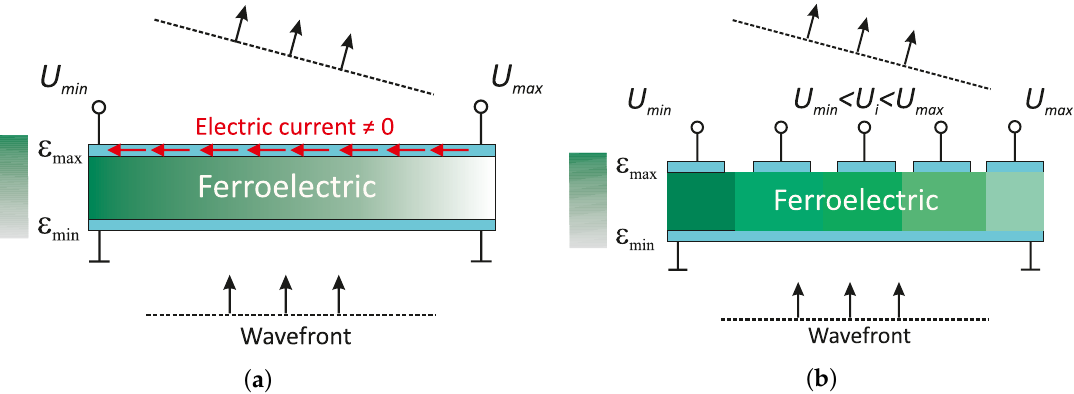
Figure 2. The FE lens schematics with different radiotransparent electrodes’ topologies: ( a ) continuous and ( b )